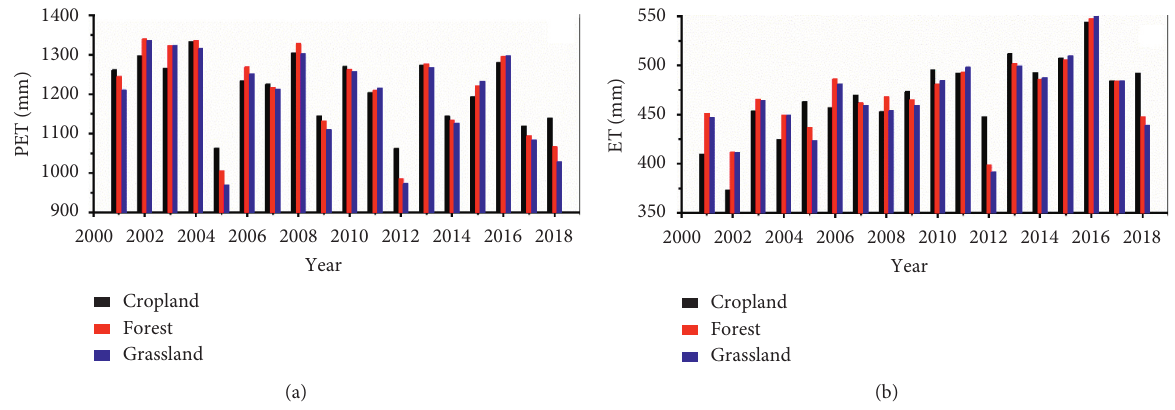
Figure 12: Changes of annual PET (a) and ET (b) in different land use over the upper Taohe River basin from 2001 to 2018.